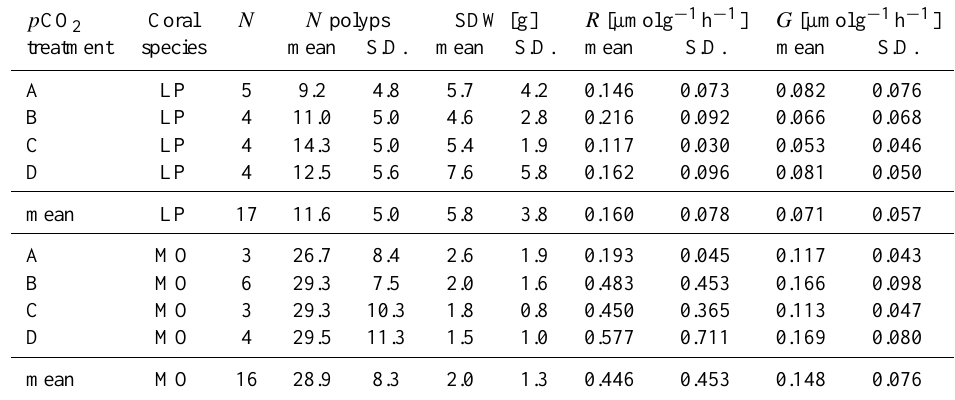
Table 1. Number of samples ( N ), number of polyps per coral fragment ( N polyps), skeletal dry weight (SDW), and rates of respiration ( R ) and calcification ( G , Maier et al., 2013) of coral fragments of L. pertusa (LP) and M. oculata (MO). Values of R and G of periods T 1 to T 4 were pooled. p CO